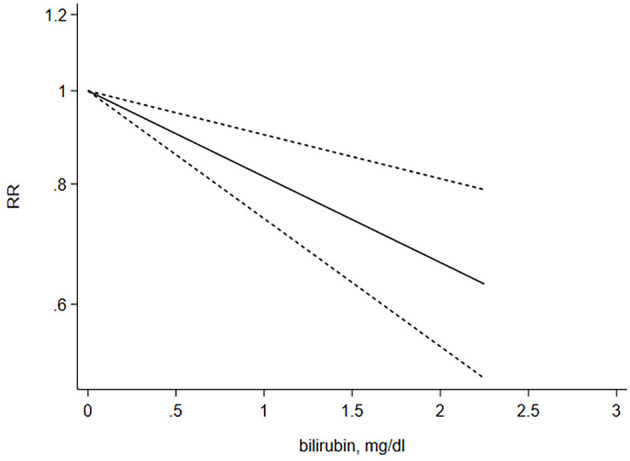
Dose–response relationship between the serum total bilirubin levels and risk of CKD. The liner dose–response model is based on restricted cubic splines for STB concentrations at three point (25, 50, 75 percentiles). The line with short dashes represents the 95% confidence intervals.